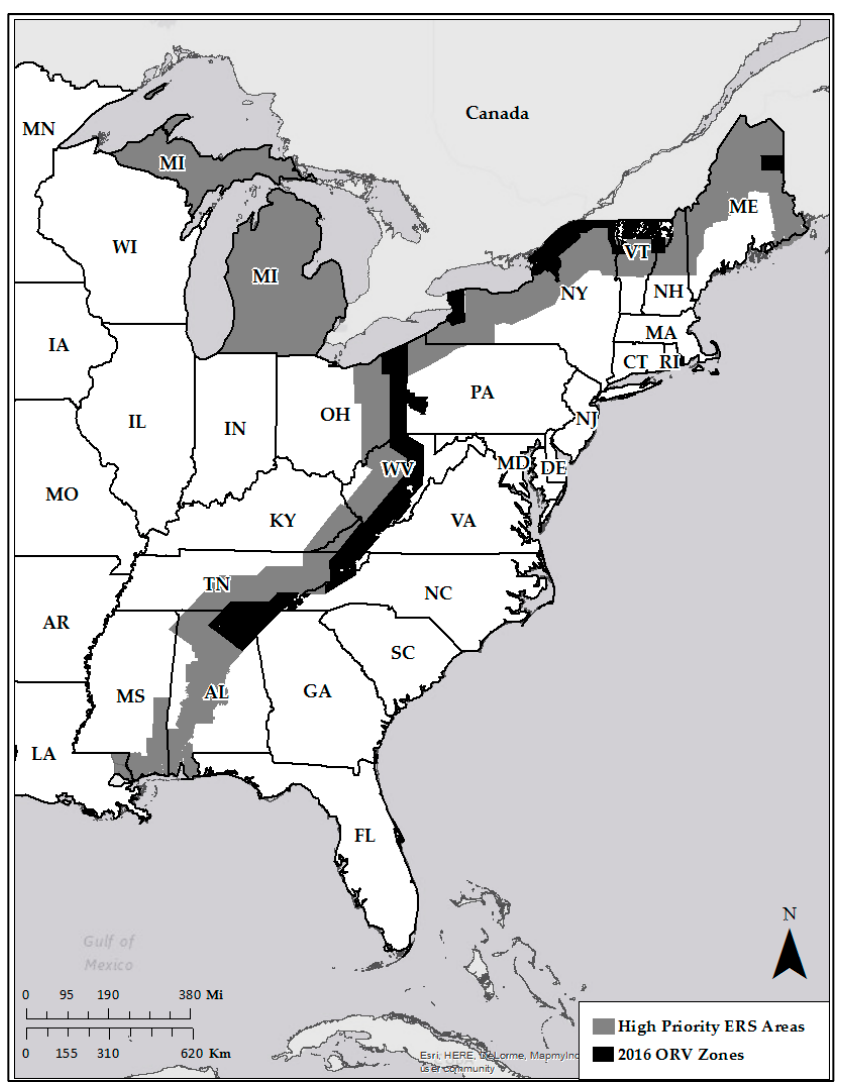
Figure 1. Highest priority enhanced rabies surveillance areas that extended 80 km west (Appalachian Ridge) or generally south (northeastern states) of current oral rabies vaccination (ORV) zones in the eastern U.S. and other critical risk areas.